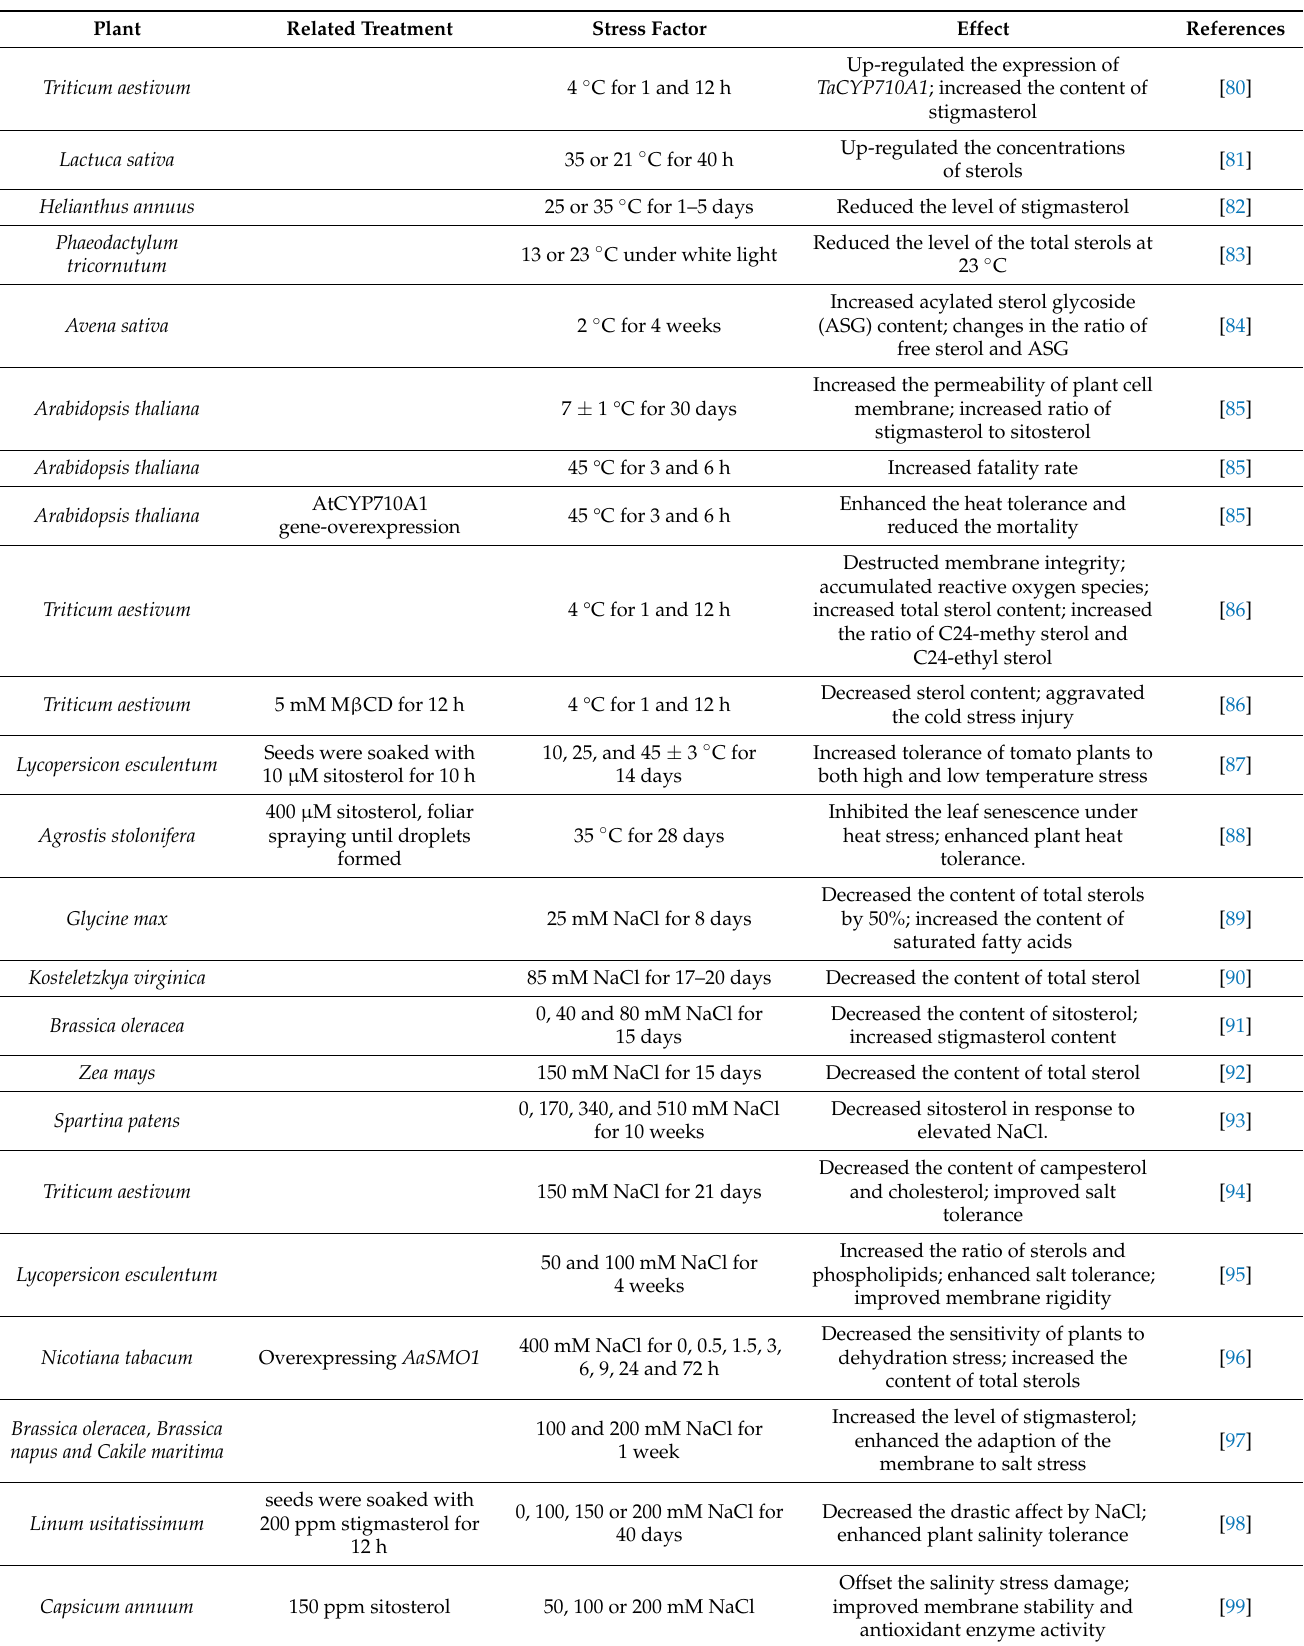
Table 1. The role of sterols in plant responses to a variety of abiotic